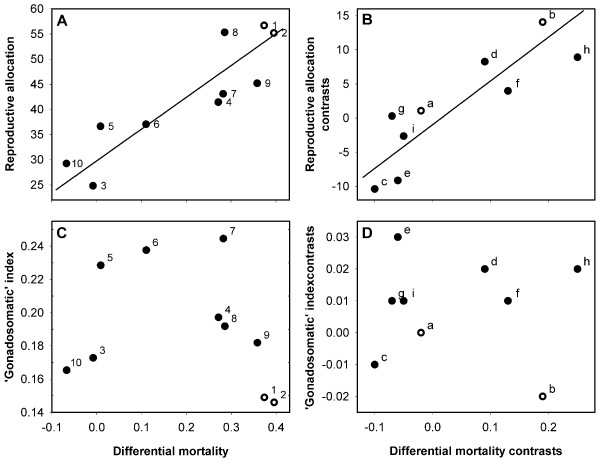
Reproductive effort versus differential extrinsic mortality for the eight parasitic castrator trematode species (operating stolen host bodies) and both genders of uninfected horn snails. Relative reproductive allocation increases with mortality using (A) raw data (r = 0.88, P = 0.0008, n = 10) and when using (B) phylogenetically independent contrasts (r = 0.87, P = 0.0026, n = 9; regression through the origin: t8 = 5.0, P = 0.0011). Relative reproductive allocation here is a modified gonadosomatic index that accounts for variation in allocation to growth by using total mass growth increment in the denominator instead of total mass. (C) and (D) show that there is no association when the raw gonadosomatic index is used to represent reproductive effort in parallel analyses (r = -0.24, P = 0.49, n = 10 and r = -0.03, P = 0.942, n = 9; regression through the origin: t8 = 0.34, P = 0.74). A two-stage randomization test ensured that these positive relationships were not statistical artifacts driven by the strong negative correlation of growth with mortality (see Additional file 1). Lines, symbols, and differential mortality are as in Figure 2.